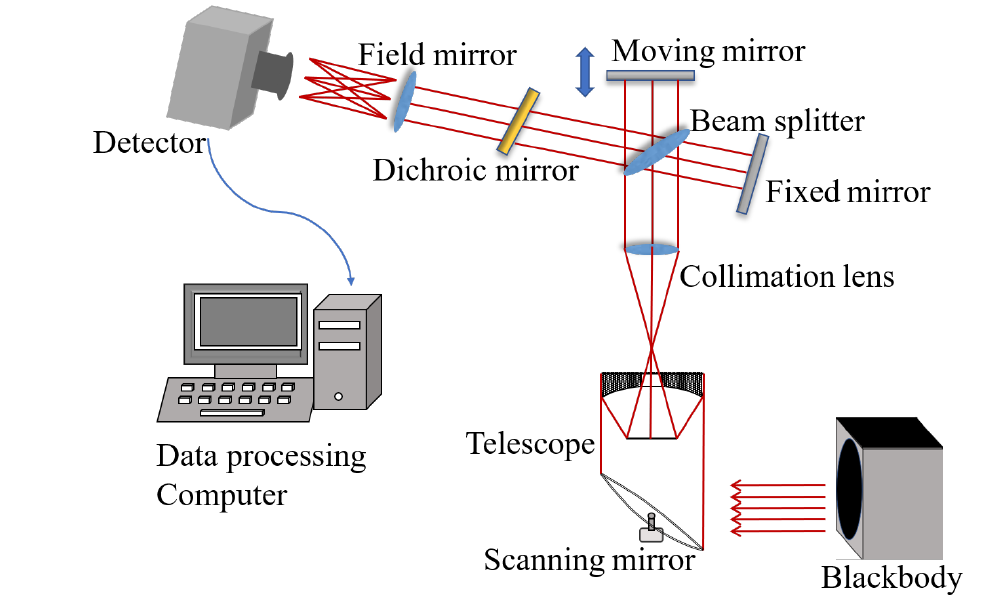
Figure 1. Experimental setup of the LWIR interference signal acquisition system.